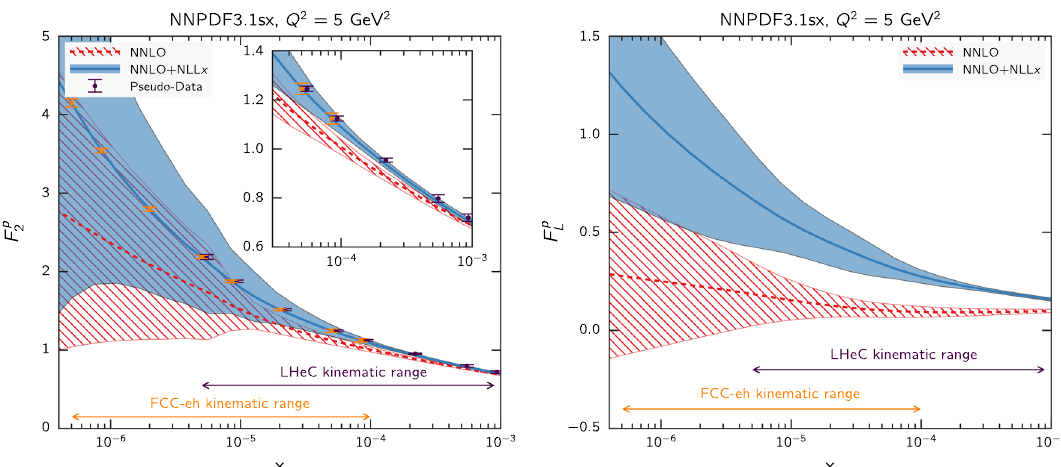
Fig. 5.15 Structure function F 2 (left) and longitudinal structure function F L (right) as a function of x for fixed Q 2 = 5GeV 2 computed in the NNLO+NLLx scheme within NNPDF3.1sx calculation (blue bands). Shown also for comparison is the NNLO prediction (red bands). Figures taken from